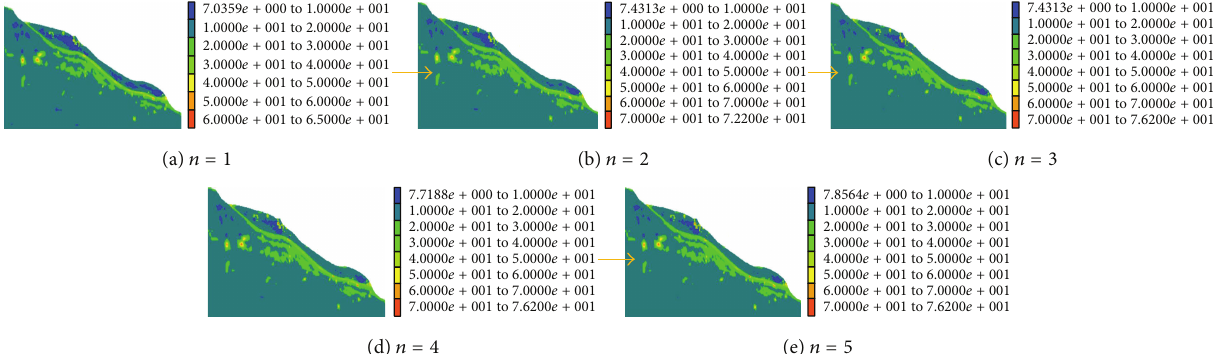
Figure 15: Acceleration amplitude nephogram of the slope.